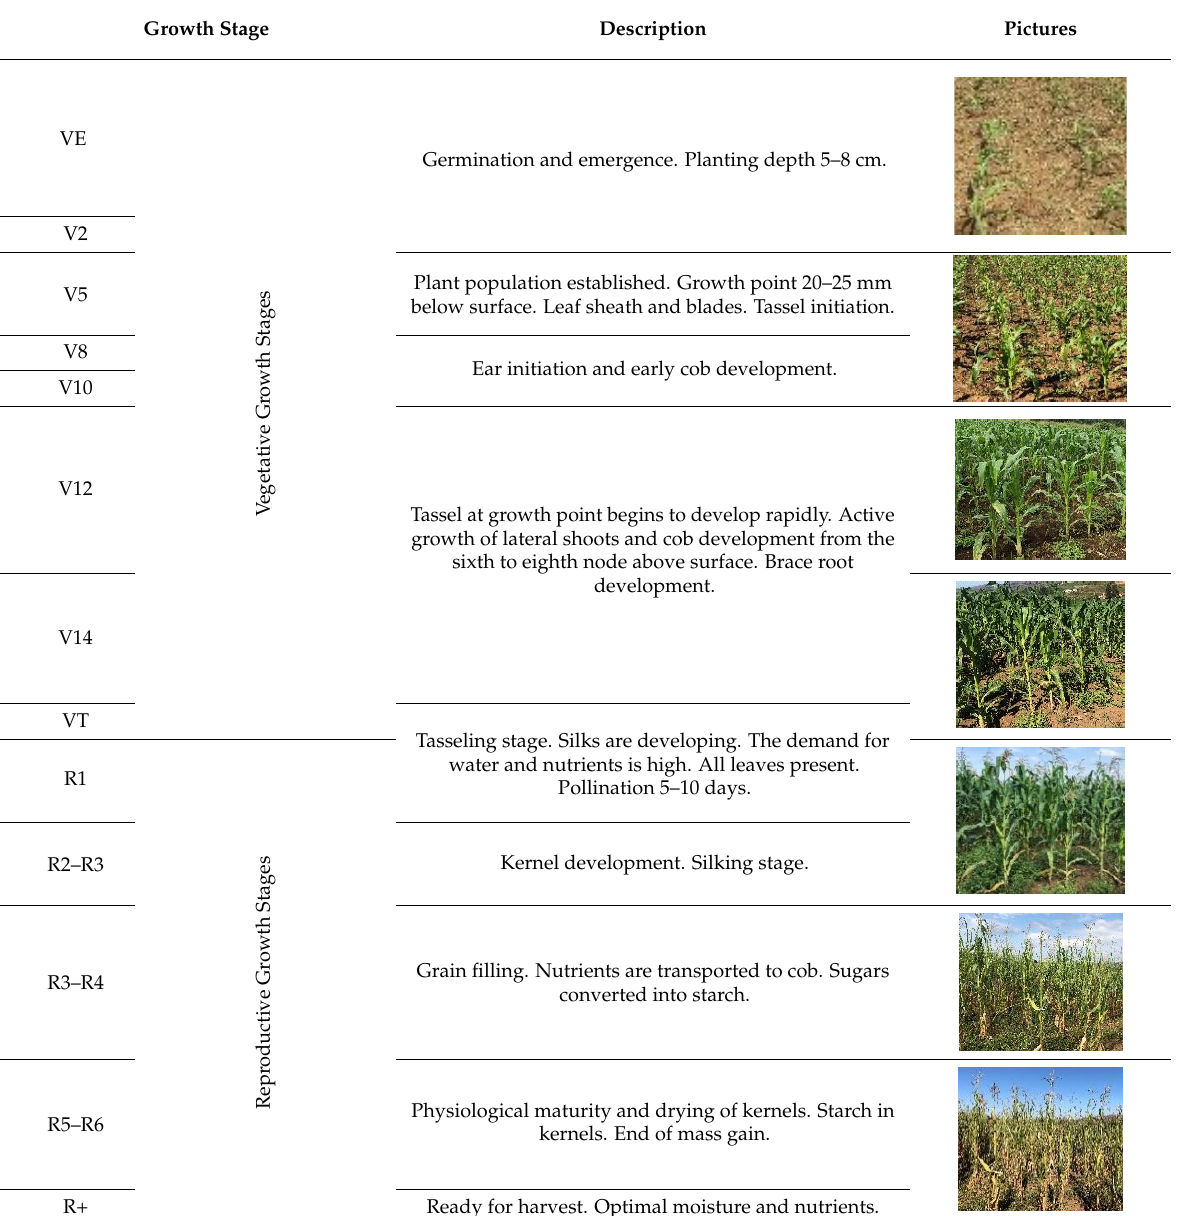
Table 1. Maize growth